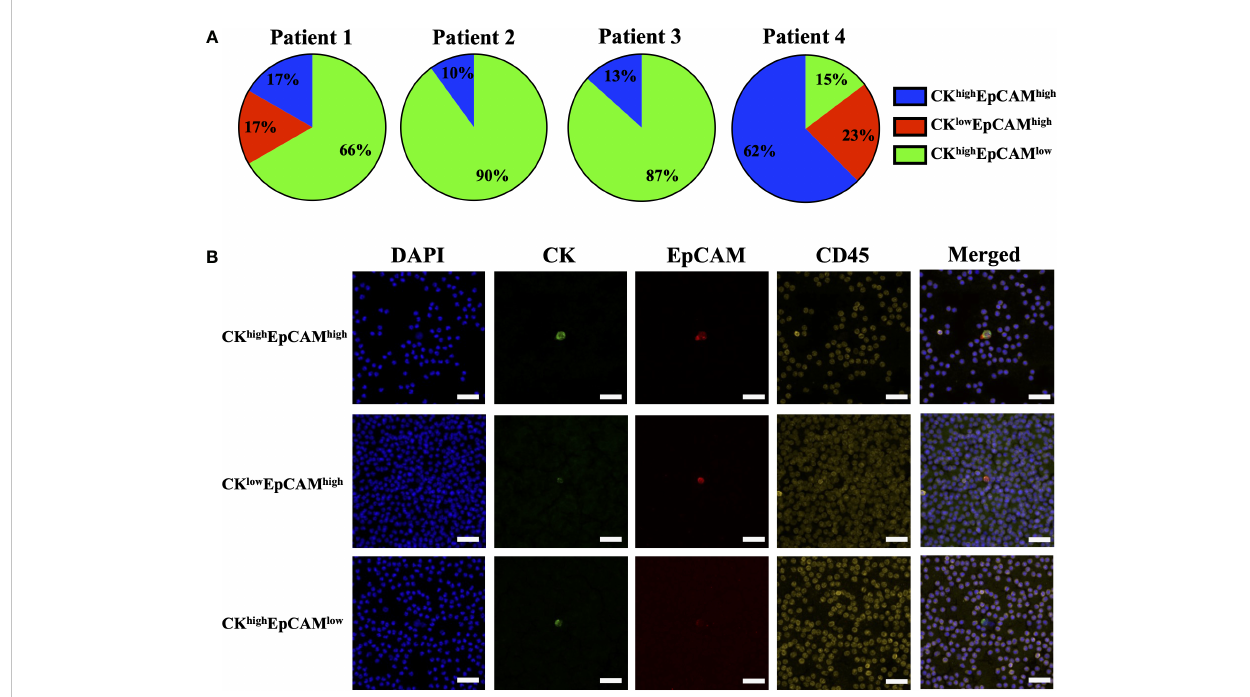
FIGURE 4 Proportions of epithelial markers in clinical sample CTCs. CTCs identi fi ed in clinical samples of patients with pancreatic cancer (Patient 1 and 2), thyroid cancer (Patient 3) and small cell lung cancer (Patient 4) had varying proportions of epithelial markers: cytokeratin (CK) and EpCAM (A) . Representative images are shown: CK high EpCAM high (top), CK low EpCAM high (middle), and CK high EpCAM low (bottom) (B) . CK (green), EpCAM (red), CD45 (yellow) and nuclear DAPI (blue). Magni fi cation = 40X; scale bar = 50 m